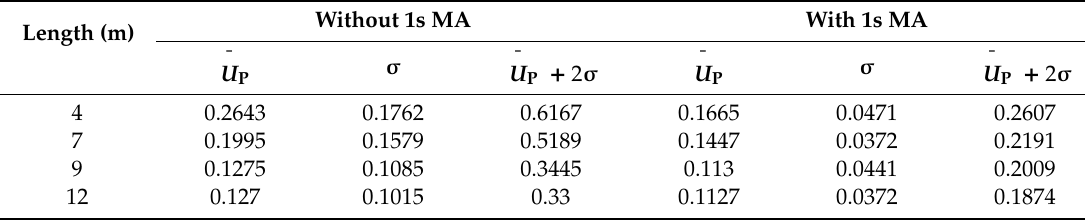
Table 3. Peak values of gust measurement without and with 1 s MA.